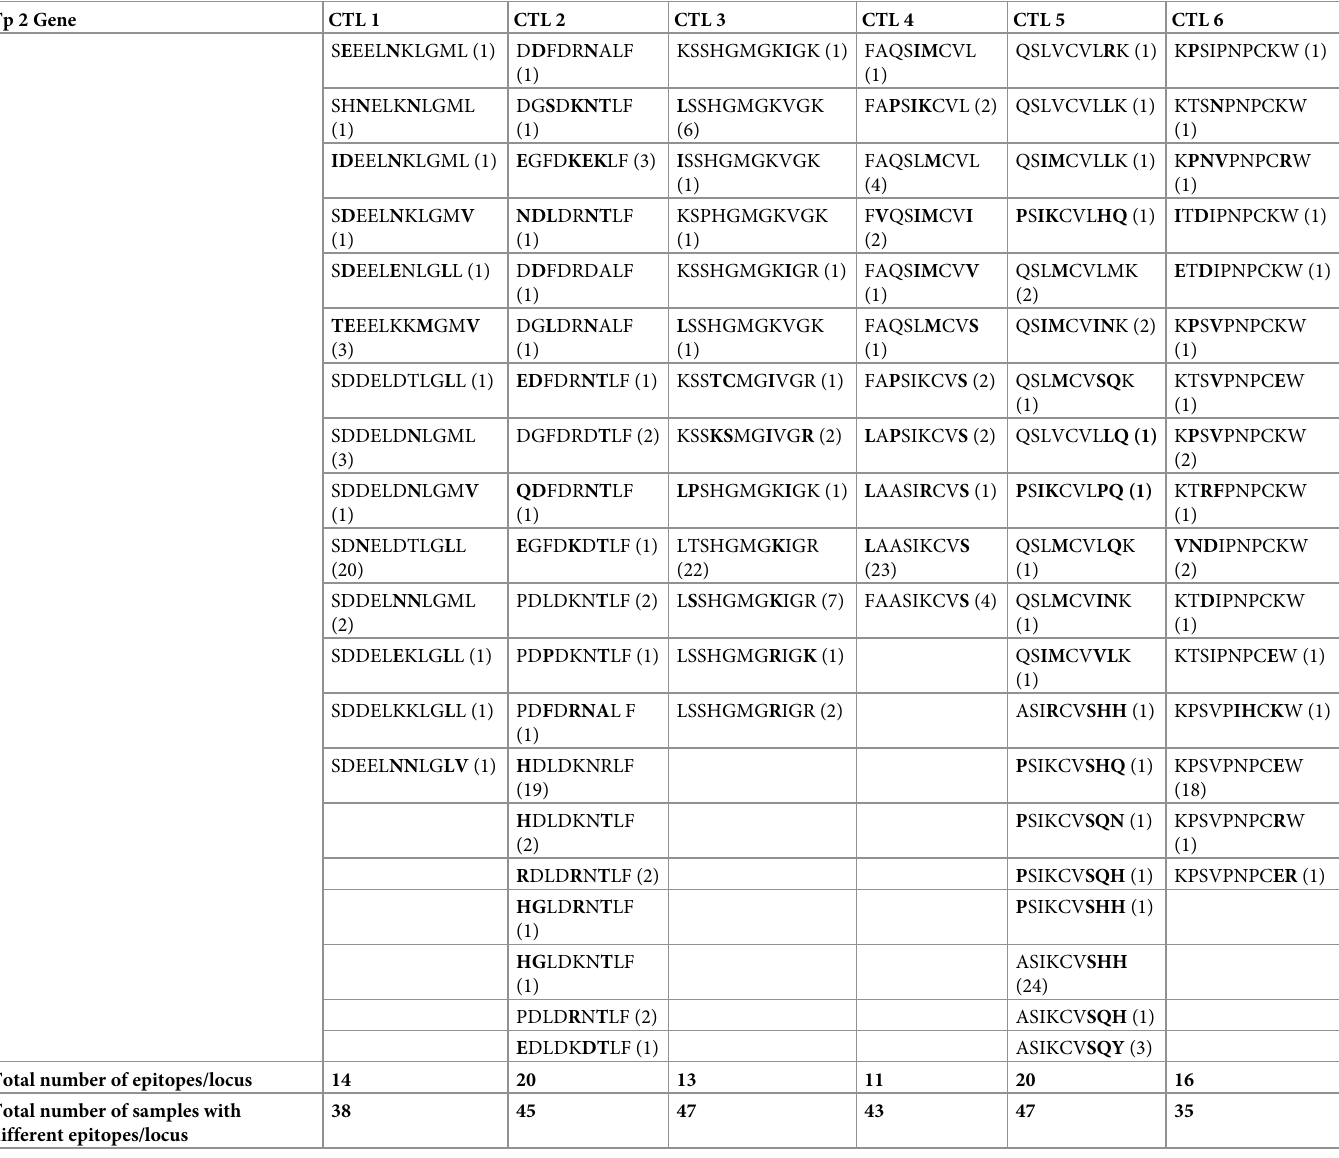
Table 4. Tp2 epitopes identified in this study from unvaccinated cattle from the different regions of Burundi that differ from Muguga cocktail epitopes. Tp 2